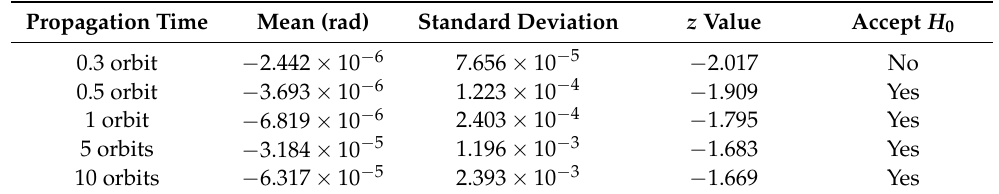
Table 3. Relative phase statistics and hypothesis testing.